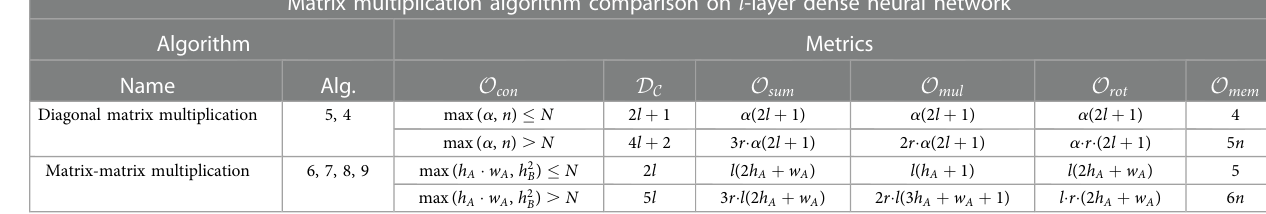
TABLE 3 Detailed comparison of the different complete matrix multiplication algorithms described in the paper according to the different metrics proposed in Section 4.1 ( O con , D C , O sum , O mul , O rot and O mem ) for a generic l -layer Neural Network. Additionally, it shows the performance variation if Rotations are as in Algorithm 10. Note that, for Algorithms 4 and 5, we can consider a ¼ n . In Algorithms 7, 8, and 9, we consider the optimization of not using Preprocessing A and considering B is a one-dimensional vector. Matrix multiplication algorithm comparison on l -layer dense neural network Algorithm Metrics